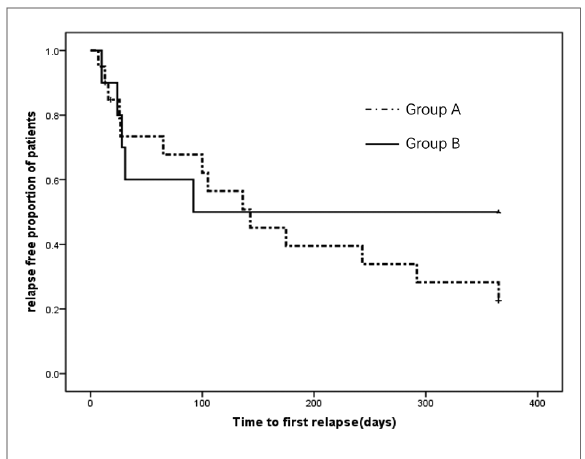
FIGURE 3 Time to fi rst relapse in participants between